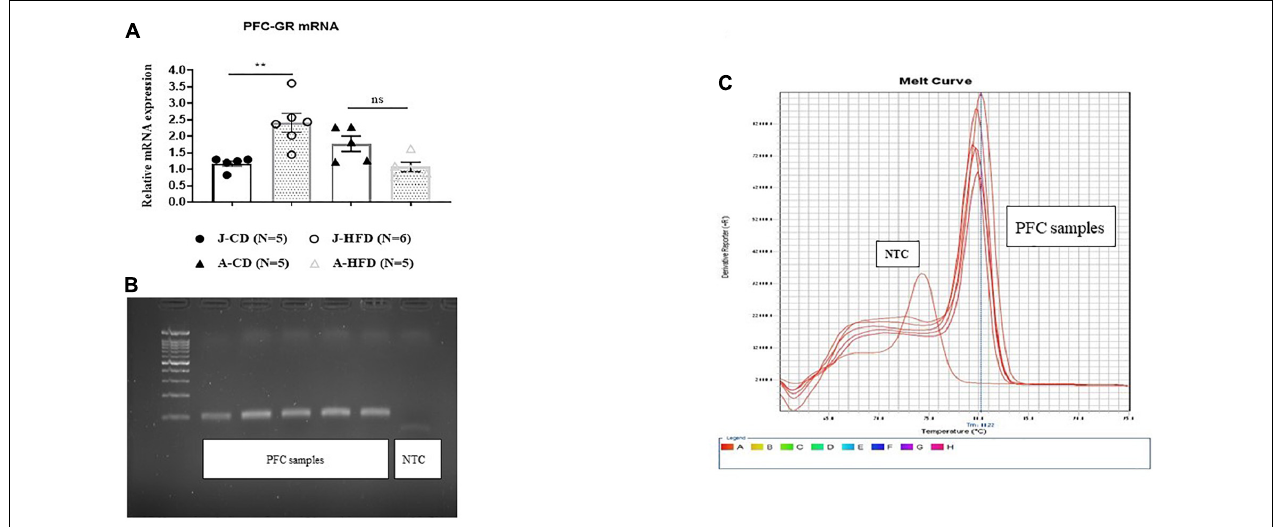
FIGURE 8 | Effects of acute HFD exposure on prefrontal cortex GR mRNA expression. (A) Prefrontal cortex (PFC) GR mRNA of juvenile (PND 28) and adult (PND 67) animals immediately after completing a 7-day HFD or CD regimen was quantified using RT-qPCR. Error bars show SEM. Univariate ANOVA analysis by Age and Diet of mRNA expression levels showed a significant effect of Age × Diet interaction ( ∗∗∗ p < 0.001), but no significant individual effects of Age (n.s) or Diet (n.s). Post hoc analysis showed significant differences in PFC GR mRNA expression between CD- and HFD-fed juveniles ( ∗∗ p < 0.01), but not adults (n.s.). (B , C) Representation of gel image and dissociation curve. Error bars show standard error of the mean